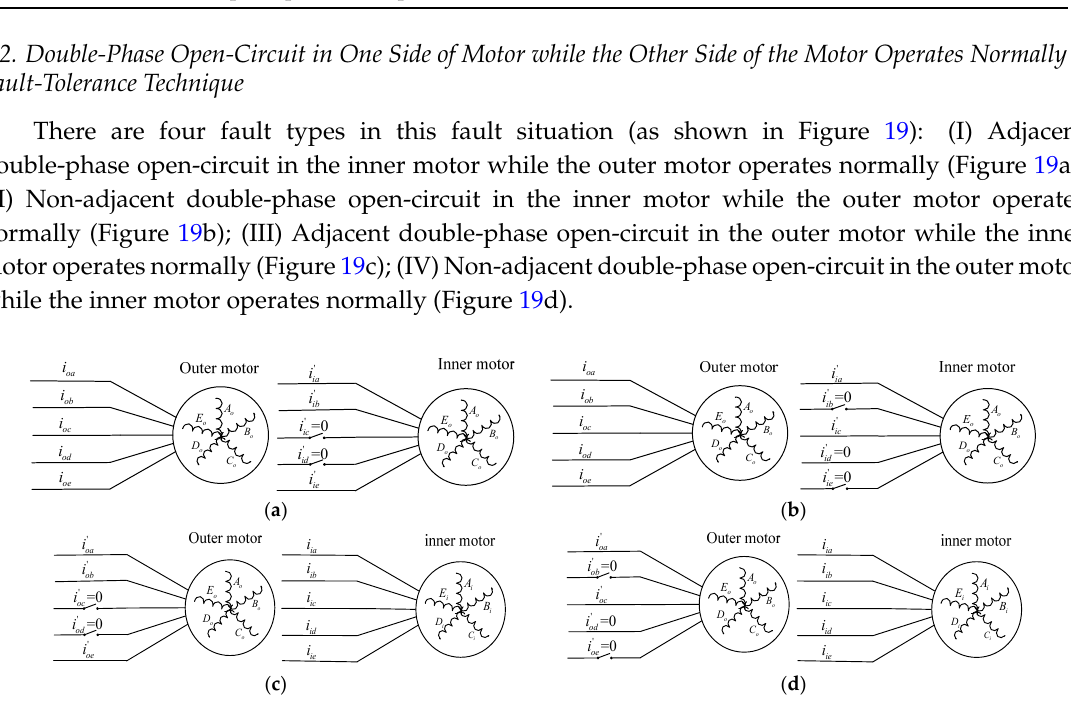
Figure 19. Four types of fault (double ‐ phase open ‐ circuit in one side motor while the other side motor operates normally). ( a ) Adjacent double ‐ phase open ‐ circuit in the inner motor; ( b ) non ‐ adjacent double ‐ phase open ‐ circuit in the inner motor; ( c ) adjacent double ‐ phase open ‐ circuit in the outer motor; ( d ) non ‐ adjacent double ‐ phase open ‐ circuit in the outer motor.